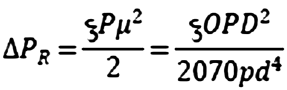
Table 7 Optimum perforated liner specification for horizontal well